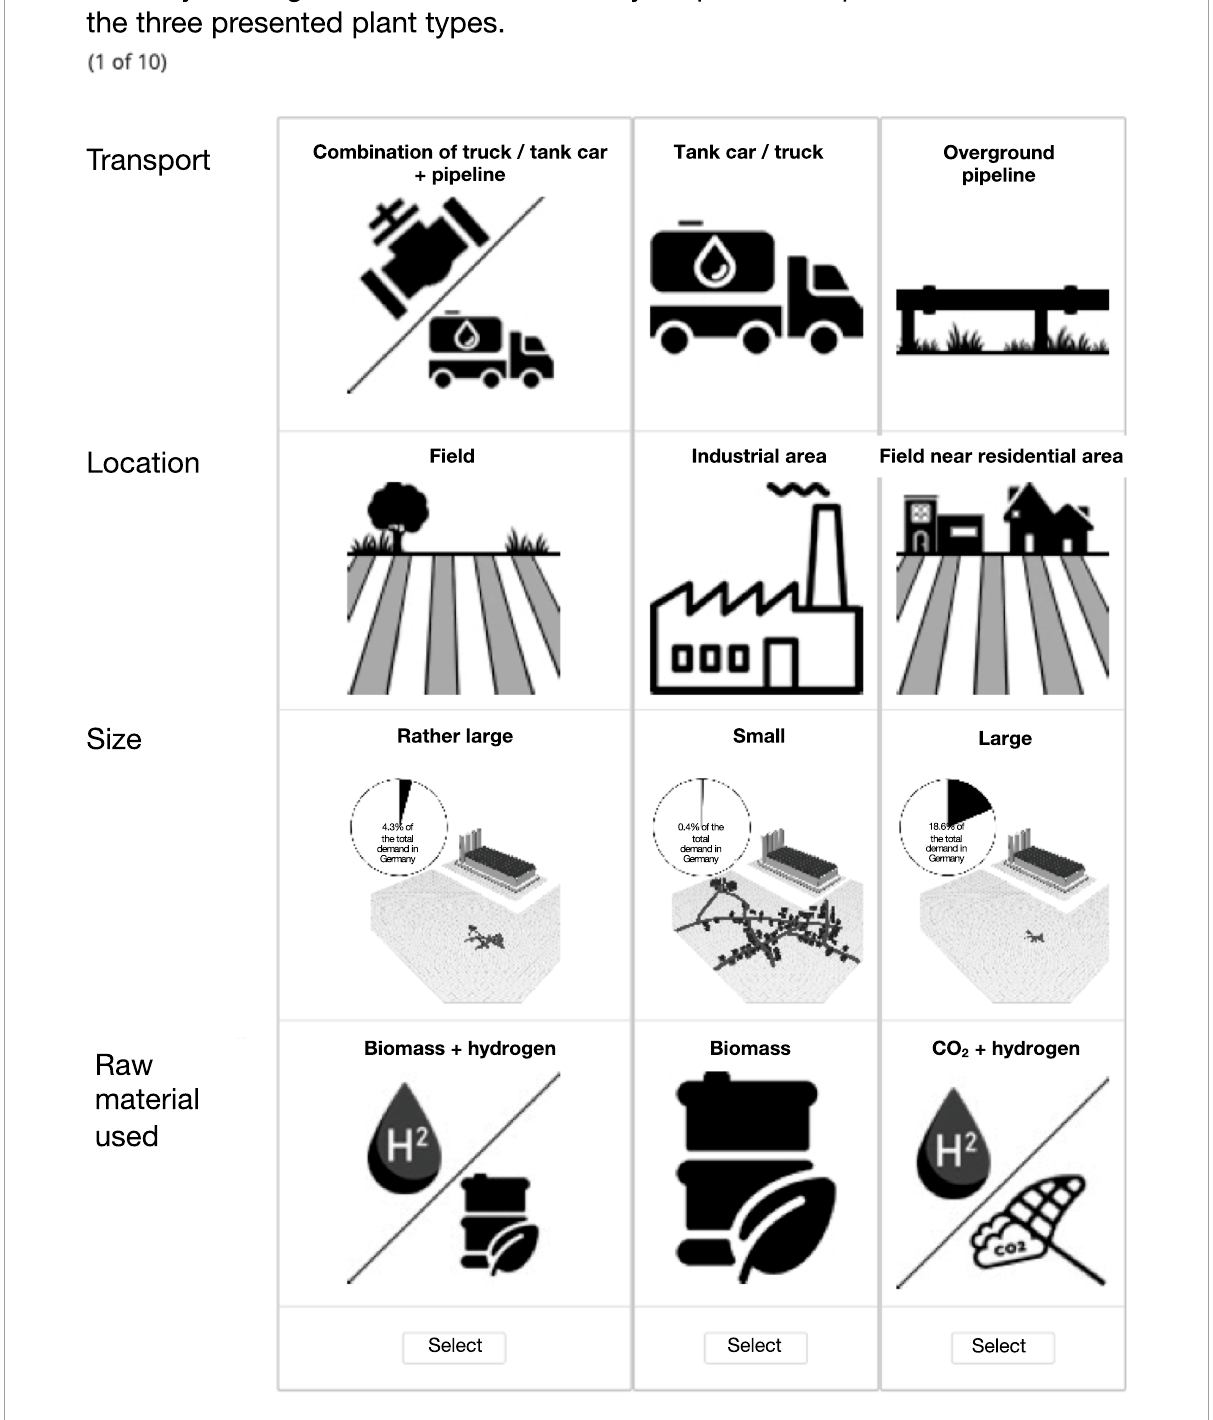
FIGURE 2 Example of a conjoint